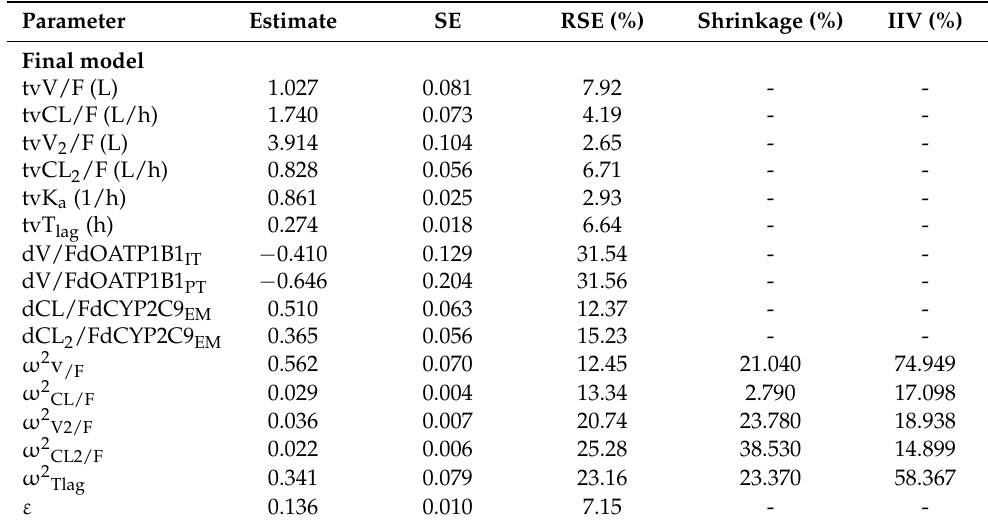
Table 4. Parameter values of the finally established human Pop-PK model for torsemide.